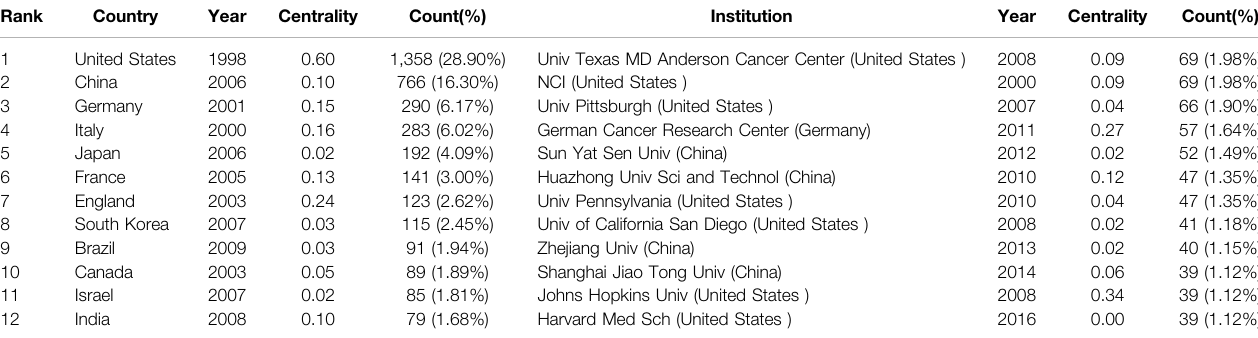
TABLE 1 | Top 12 country/region and institutions related to the in fl ammatory tumor microenvironment.